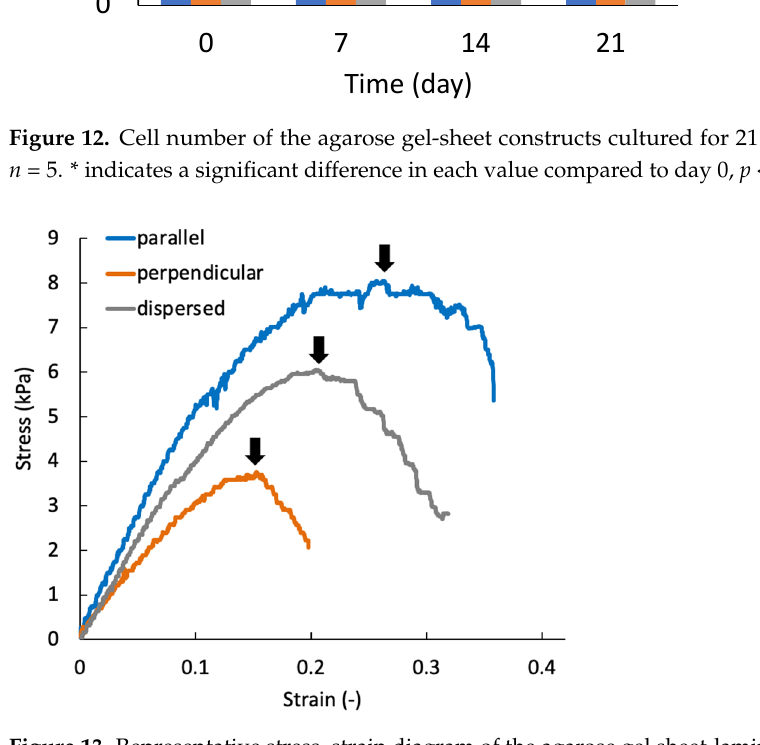
Figure 13. Representative stress–strain diagram of the agarose gel sheet-laminated construct containing chondrocytes cultured for 21 days. Black arrows indicate the rupture point of each specimen.